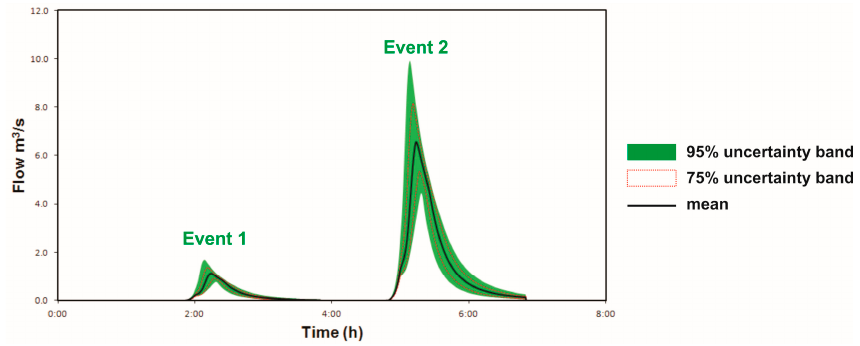
Figure 7. Uncertainty bands and mean of the urban flood hydrograph using the proposed methodology.